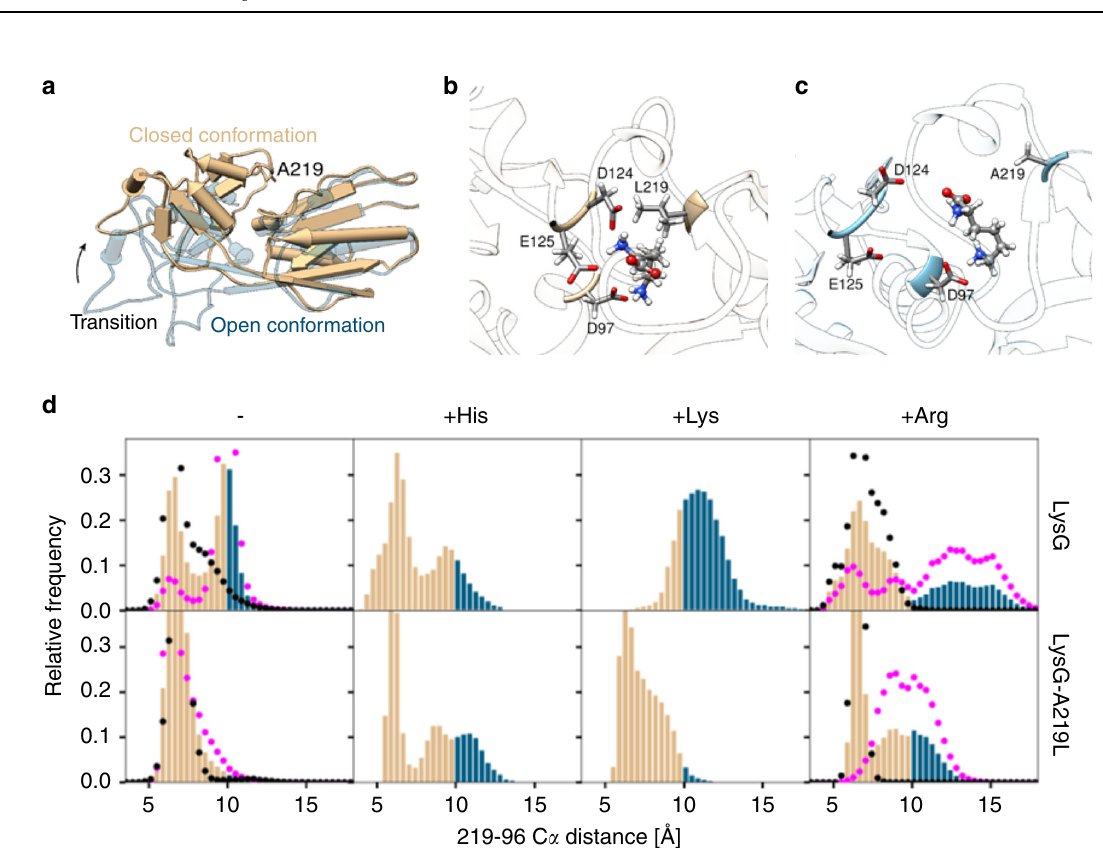
Fig. 4 Distribution of open and closed conformations of LysG and LysG-A219L binding domains. a The 2 µ s simulation of LysG and 2 µ s simulation of LysG-A219L. Both samples have an open (blue) and closed (tan) conformation of the ligand-binding domain, where openness is de fi ned by distance >10 Å between atoms 96 C α and 219 C α . It is proposed that the open conformation corresponds to an eyfp fl uorescence promoting sensor. b Three predominant hydrogen bridges between L -lysine and the L219 linker stabilize the closed conformation in LysG-A219L. c Wedge function of LysG that forces the open conformation of the regulator to remain stable. d Distributions of open (blue) and closed (tan) conformations as sampled in simulations for TRs LysG (two times 1 µ s — black (from crystal conformation) and magenta (from open start conformation) dots) and LysG-A219L (two times 1 µ s — magenta and black dots), and for complexes of both sensors with ligands L -lysine and L -histidine in the respective binding site (four times 250 ns). For L -arginine, joint distance distributions from two starting con fi gurations are shown (four times 250 ns — black (from crystal conformation) and magenta (from rotated ligand conformation)